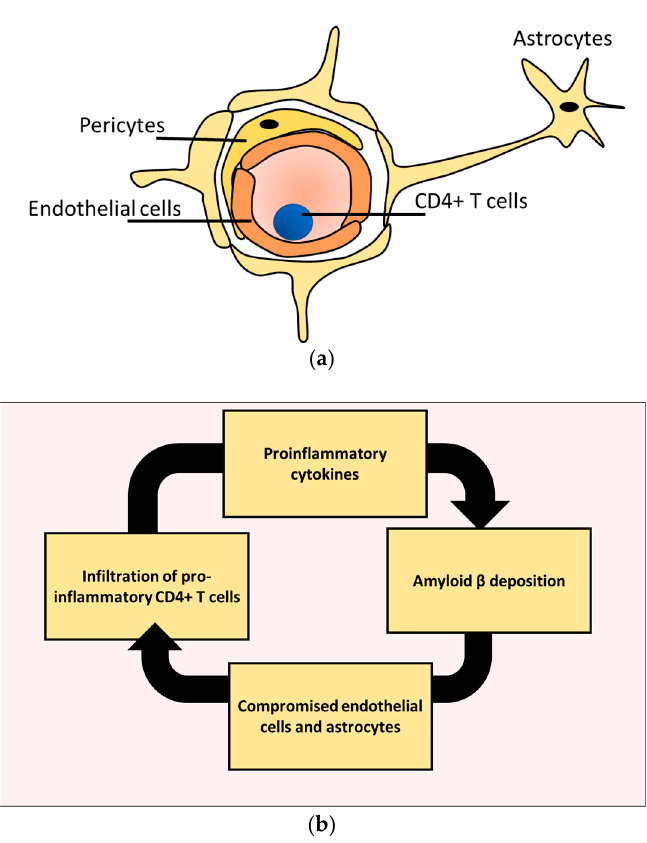
Figure 2. NVU is subjected to a vicious cycle of destruction in AD. ( a ) The main building blocks of the NVU unit includes endothelial cells, astrocytes, and pericytes. ( b ) Amyloid B deposition causes the BBB to lose its integrity, which in turn promotes infiltration of proinflammatory CD4+ T cells. Migrating CD4+ T cells produce proinflammatory cytokines that further increase the depiction of amyloid B.